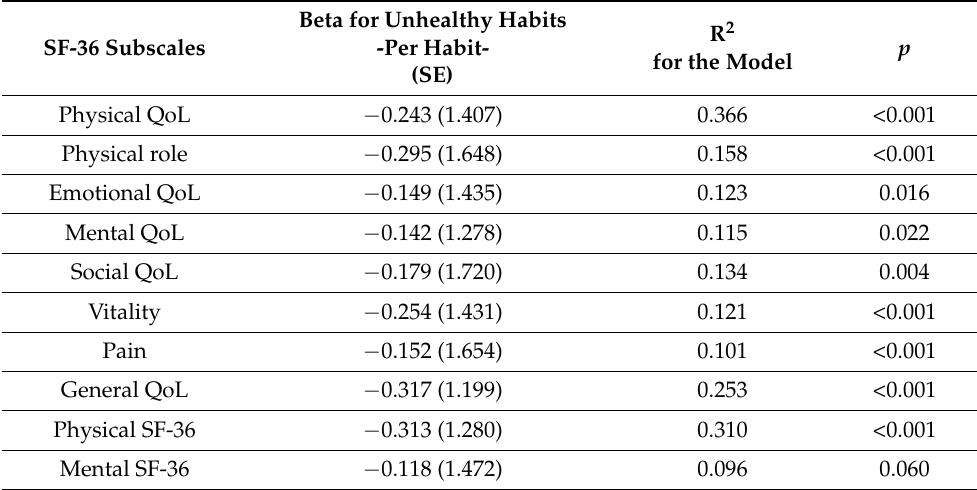
Table 3. Multivariate analysis of SF-36 QoL subscales association to the aggregate of unhealthy habits, adjusted by age, sex, CCI and depression.